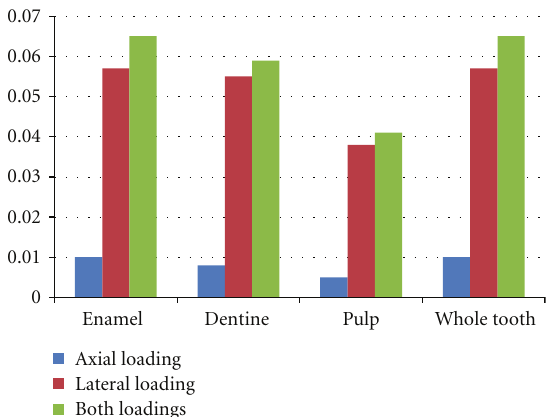
Figure 8: Strains (mm) of tooth tissues under di ff erent loading